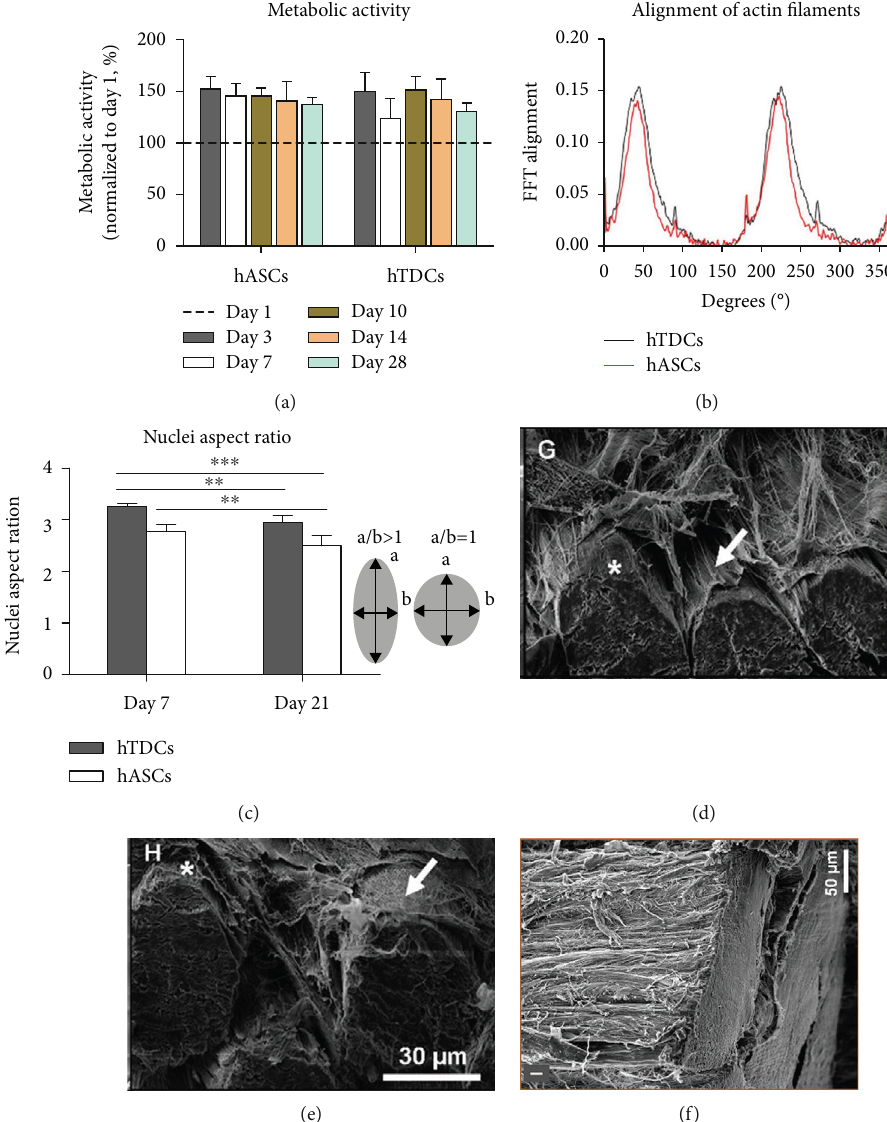
Figure 5: (a) Metabolic activity of seeded human adipose stem cells (hASCs) and human tendon-derived cells (hTDCs) between 1 and 28 days, (b) frequency plot of actin fi lament alignment at 21 days between hASCs and hTDCs, (c) nuclei aspect ratio of hASCs and hTDCs, (d) SEM image 3D sca ff old seeded with hTDCs showed complete covering of ECM, (e) SEM image 3D sca ff old seeded with hASCs showed covering of ECM, and (f) SEM image of bovine posterior ligament. Reproduced with permission from reference